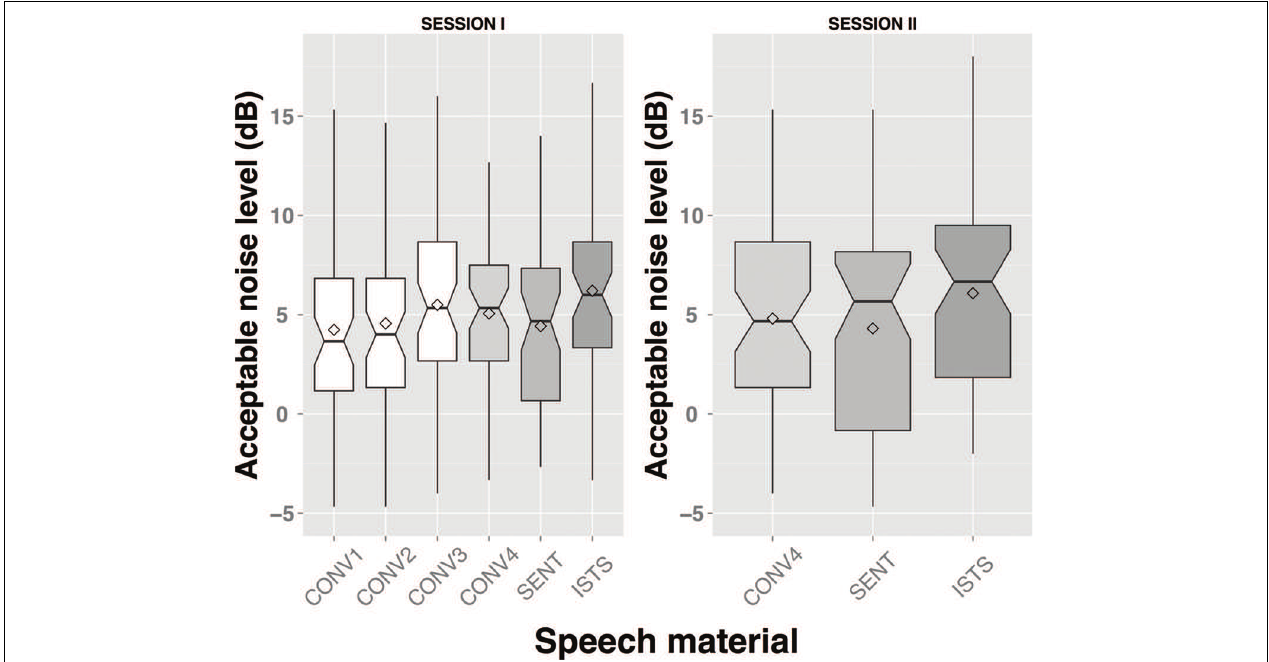
FIGURE 2 | Acceptable noise level (ANL) test results per speech material and per test session. Note that the notch plots include a marker for the mean (diamond symbol).